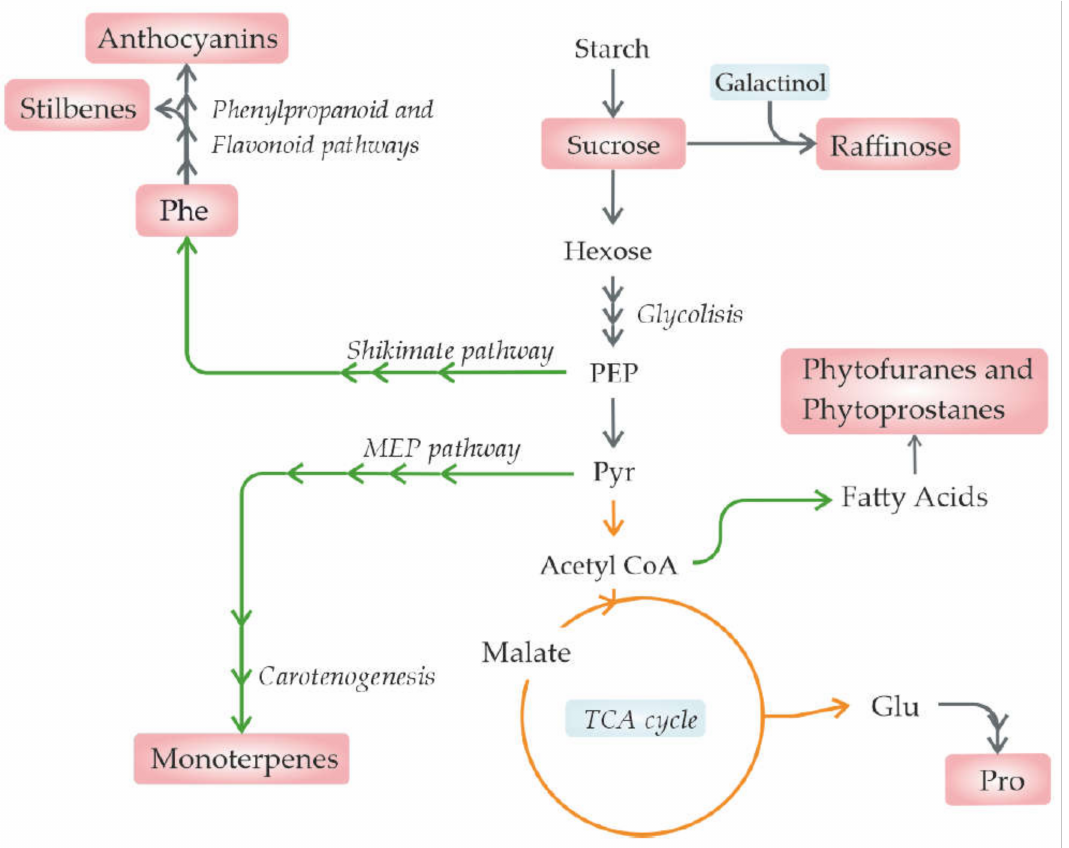
Figure 2. General effects of drought stress in fruit metabolism. Red: increase; and blue: decrease. Arrows: grey: cytosol; orange: mitochondria; and green: